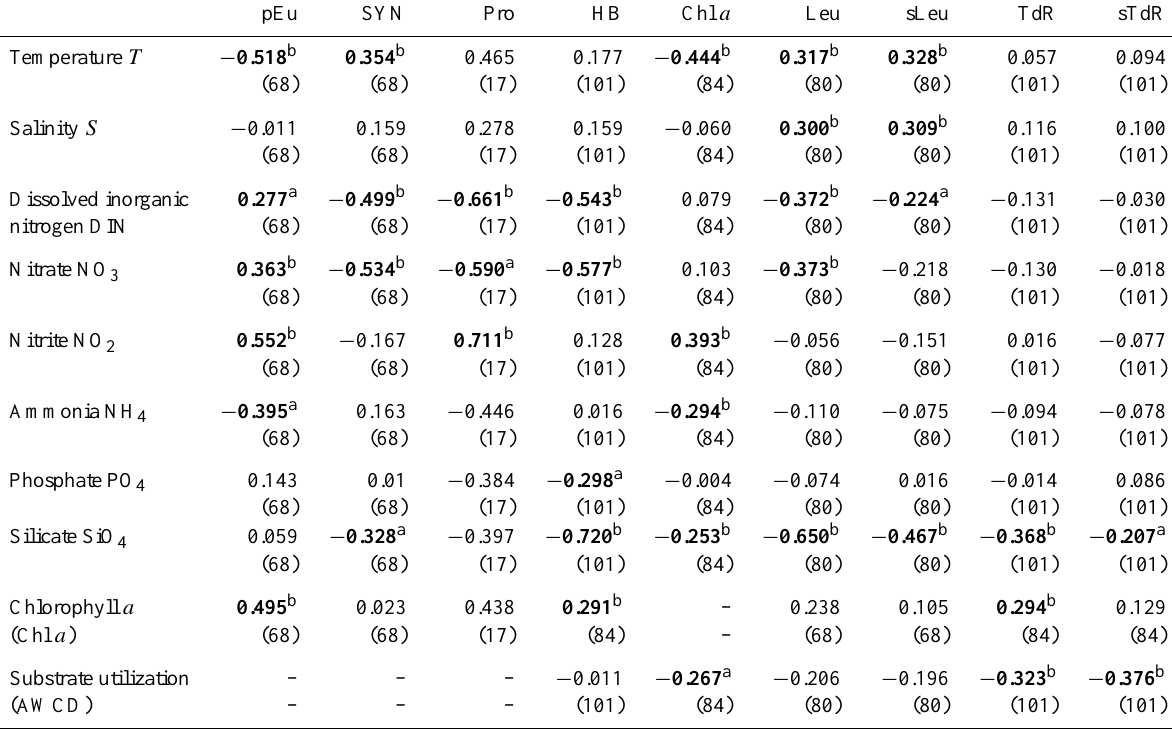
Table 2. Standardized correlation coefficients ( r ) for correlations between abundances of picoplankton, bulk cell specific prokaryotic het- erotrophic production and environmental parameters. The number of data is given in parenthesis. All data were log or log( x + 1) transformed and significant correlations (in bold) are at a p < 0 . 05, b p < 0 . 001. pEu – picoeukaryotes, SYN – Synechococcus , Pro – Prochlorococcus , HP – heterotrophic prokaryotes, bulk and cell-specific prokaryotic rates for leucine (Leu, sLeu) and thymidine (TdR, sTdR)